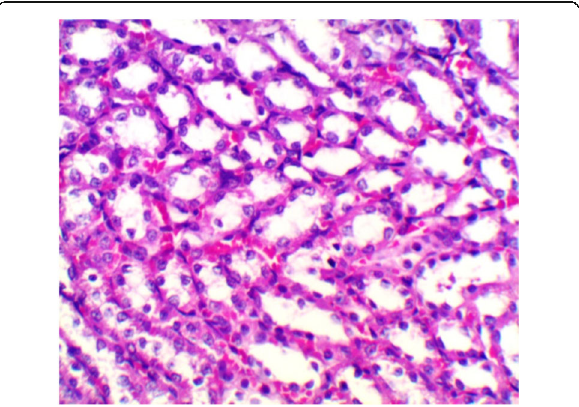
Fig. 18 Photomicrograph of treated kidney sections treated (CCL4 +